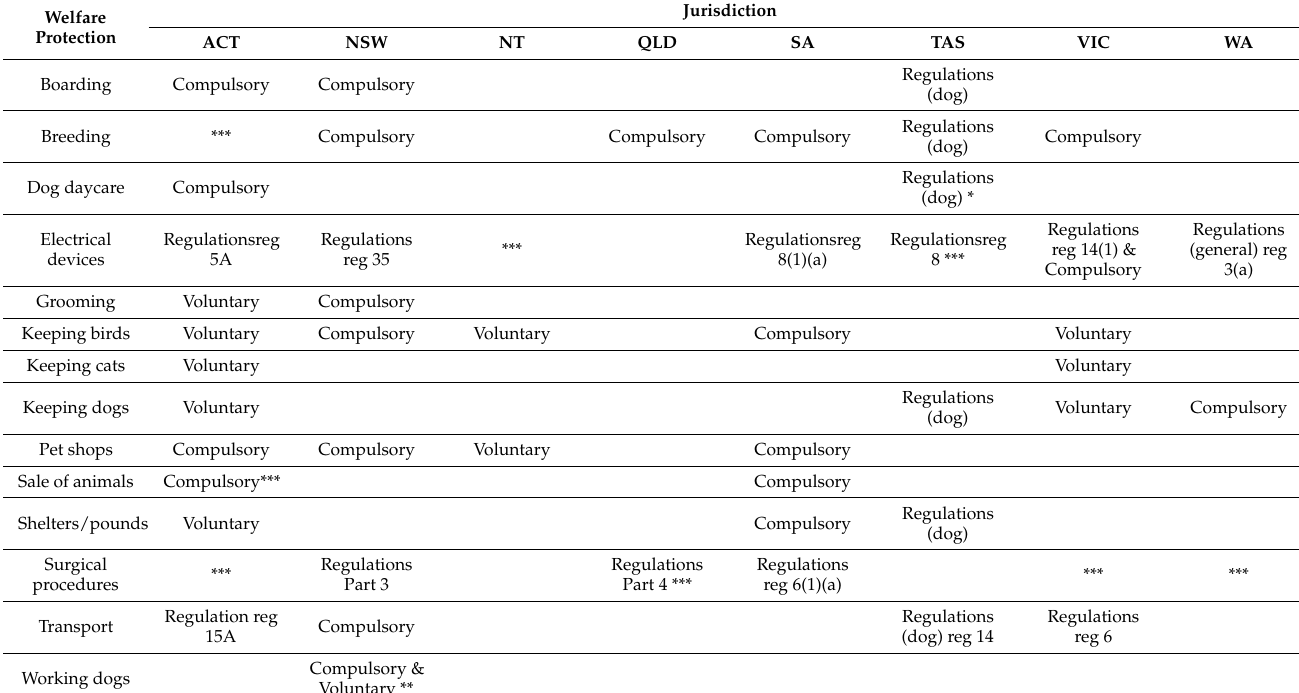
Table 3. Areas of welfare protection assigned to companion animals via subordinate legislation in each Australian jurisdiction. The terms ‘compulsory’ and ‘voluntary’ refer to the status of the code of practice. For a detailed list of all compulsory and voluntary codes, refer to, Appendices A and B respectively. This table is not intended to be an exhaustive list of all areas of companion animal protection, just of those areas that were identified from the search